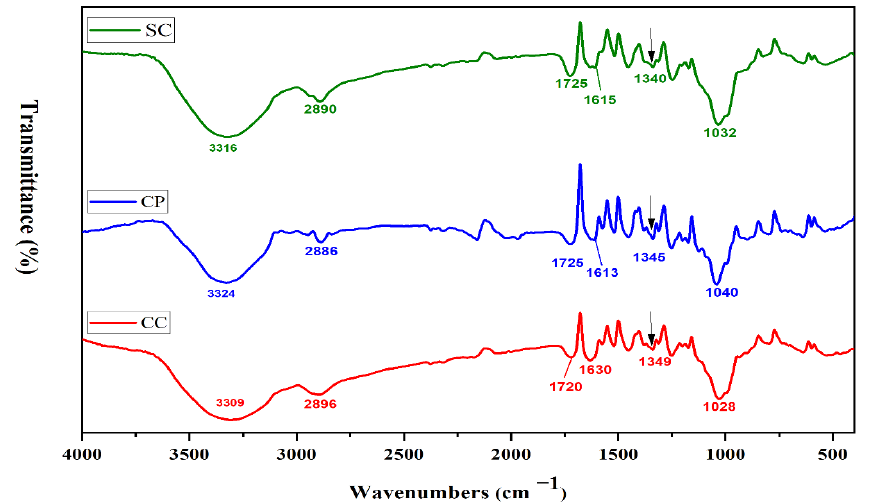
Figure 1. The FTIR spectra of lignocellulosic biomasses, including corn cob (CC), cornstalk piths (CP) and sugarcane bagasse (SC). Table 1. The total crystalline index (TCI) from FTIR parameters for crystallinity assessment and the crystallinity index (CrI%) from XRD data of adsorbents; including corn cob (CC), cornstalk piths (CP) and sugarcane bagasse (SC). Means with different letters ( a , b , c ) within each column indicate statistically significant differences between the samples after Duncan ’ s analysis ( p < 0.05).